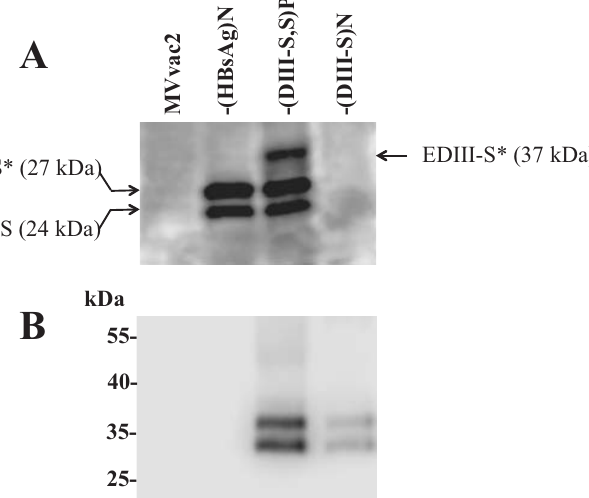
Figure 3. Analysis of expression of the hybrid DIII-HBsAg in lysates from recombinant MV-infected cells (indicated on the top of each panel). In ( A ) SDS-PAGE under non-reducing conditions using a monoclonal antibody against HBsAg (the S antigen); the molecular weight of the two forms of S are shown to the left and the molecular weight of the hybrid DIII-S to the right. The asterisk indicates glycosylated forms. In ( B ) SDS-PAGE under reducing conditions using a monoclonal antibody against dengue envelope protein domain